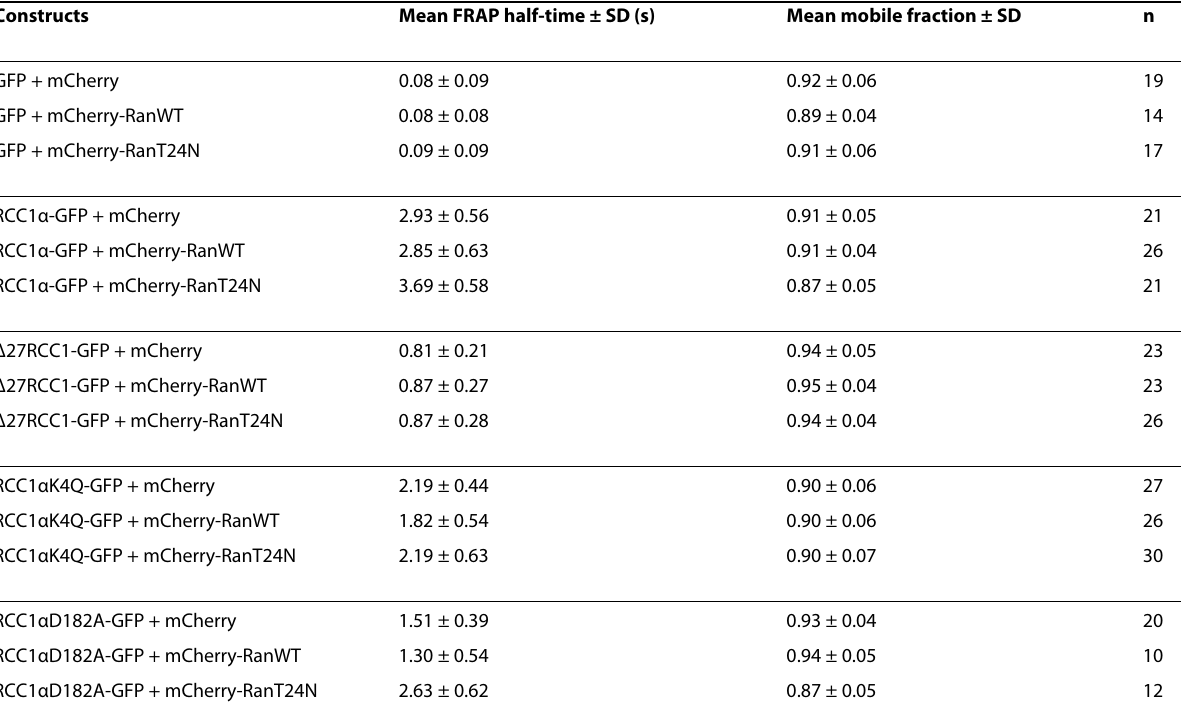
Fluorescence recovery after photobleaching (FRAP) data derived from live U2OS cells co-expressing GFP, RCC1α-GFP, Δ27RCC1-GFP, RCC1α K4Q- GFP, RCC1αD182A. The table summarises the mean +/- standard deviation (SD) of FRAP half-time and mobile fraction of each of the GFP